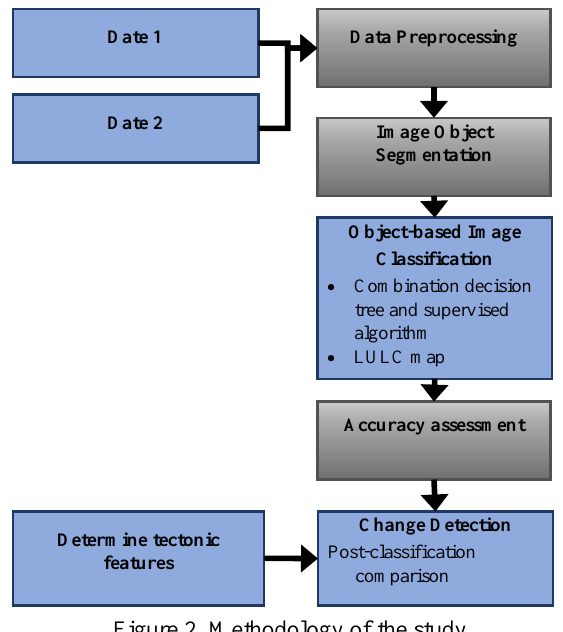
Figure 2. Methodology of the